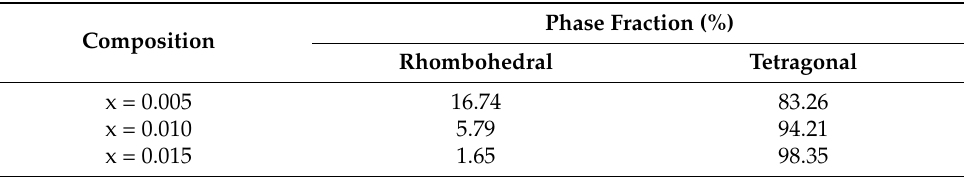
Figure 4. ( a ) XRD patterns of 0.96(K 0.46 − x Na 0.54 − x )Nb 0.95 Sb 0.05 O 3 -0.04Bi 0.5 (Na 0.82 K 0.18 ) 0.5 ZrO 3 ce- ramics sintered at 1085 ◦ C for 4 h. ( b ) Finely scanned XRD patterns for (200) C peaks of x = 0.005, 0.010, and 0.015 specimens. ( c ) Dielectric constant vs. temperature curves of x = 0.005, 0.010, and 0.015 specimens. Table 1. Phase fraction of the rhombohedral and tetragonal phases in x = 0.005, 0.010, and 0.015 speci- mens sintered at 1085 ◦ C for 4